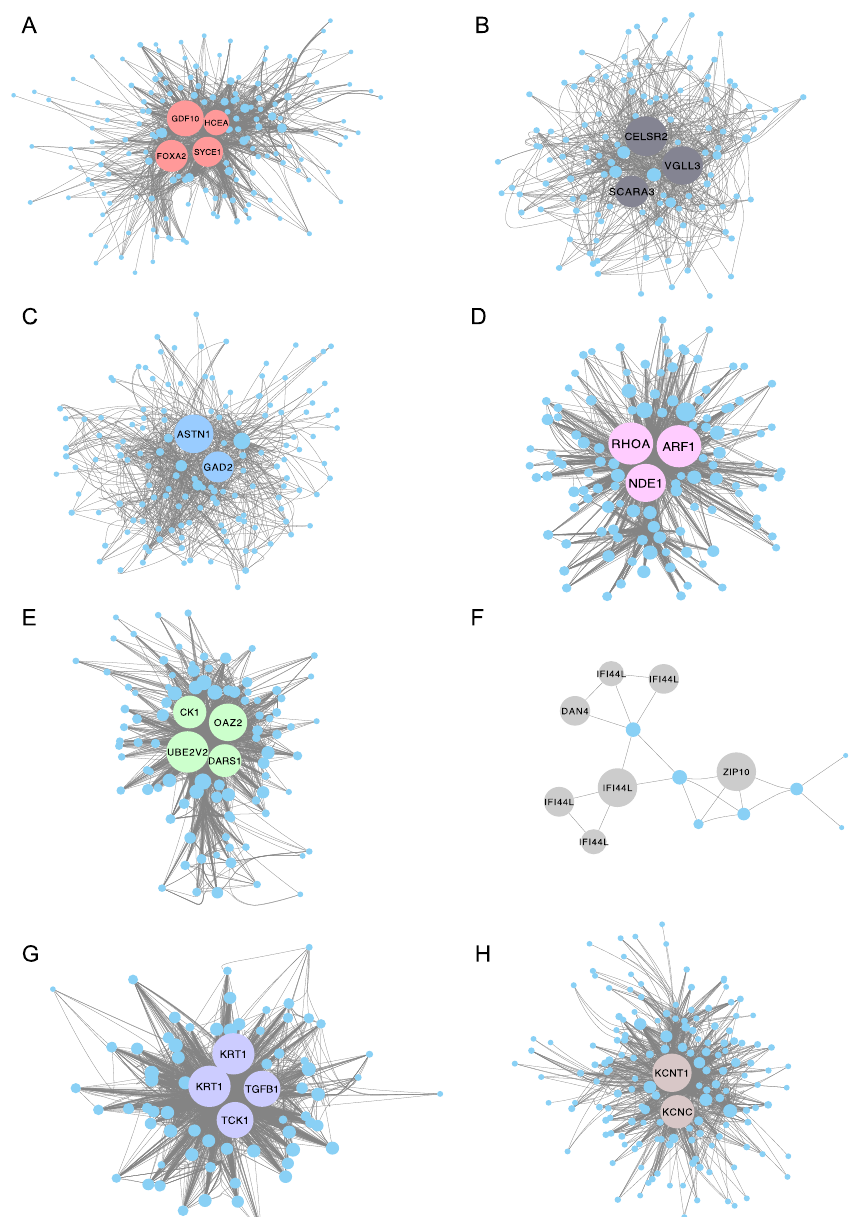
Figure 8. Protein–protein interaction (PPI) network for eight interested modules in channel catfish, Ictalurus punctatus , predicted by Cytoscape. The node degree of genes was represented using circumference of nodes. The genes with red, green, grey or purple color represent the hub genes in the ( A ) turquoise module, ( B ) black module, ( C ) blue module, ( D ) pink module, ( E ) green module, ( F ) grey module, ( G ) purple module and ( H ) brown module, separately.